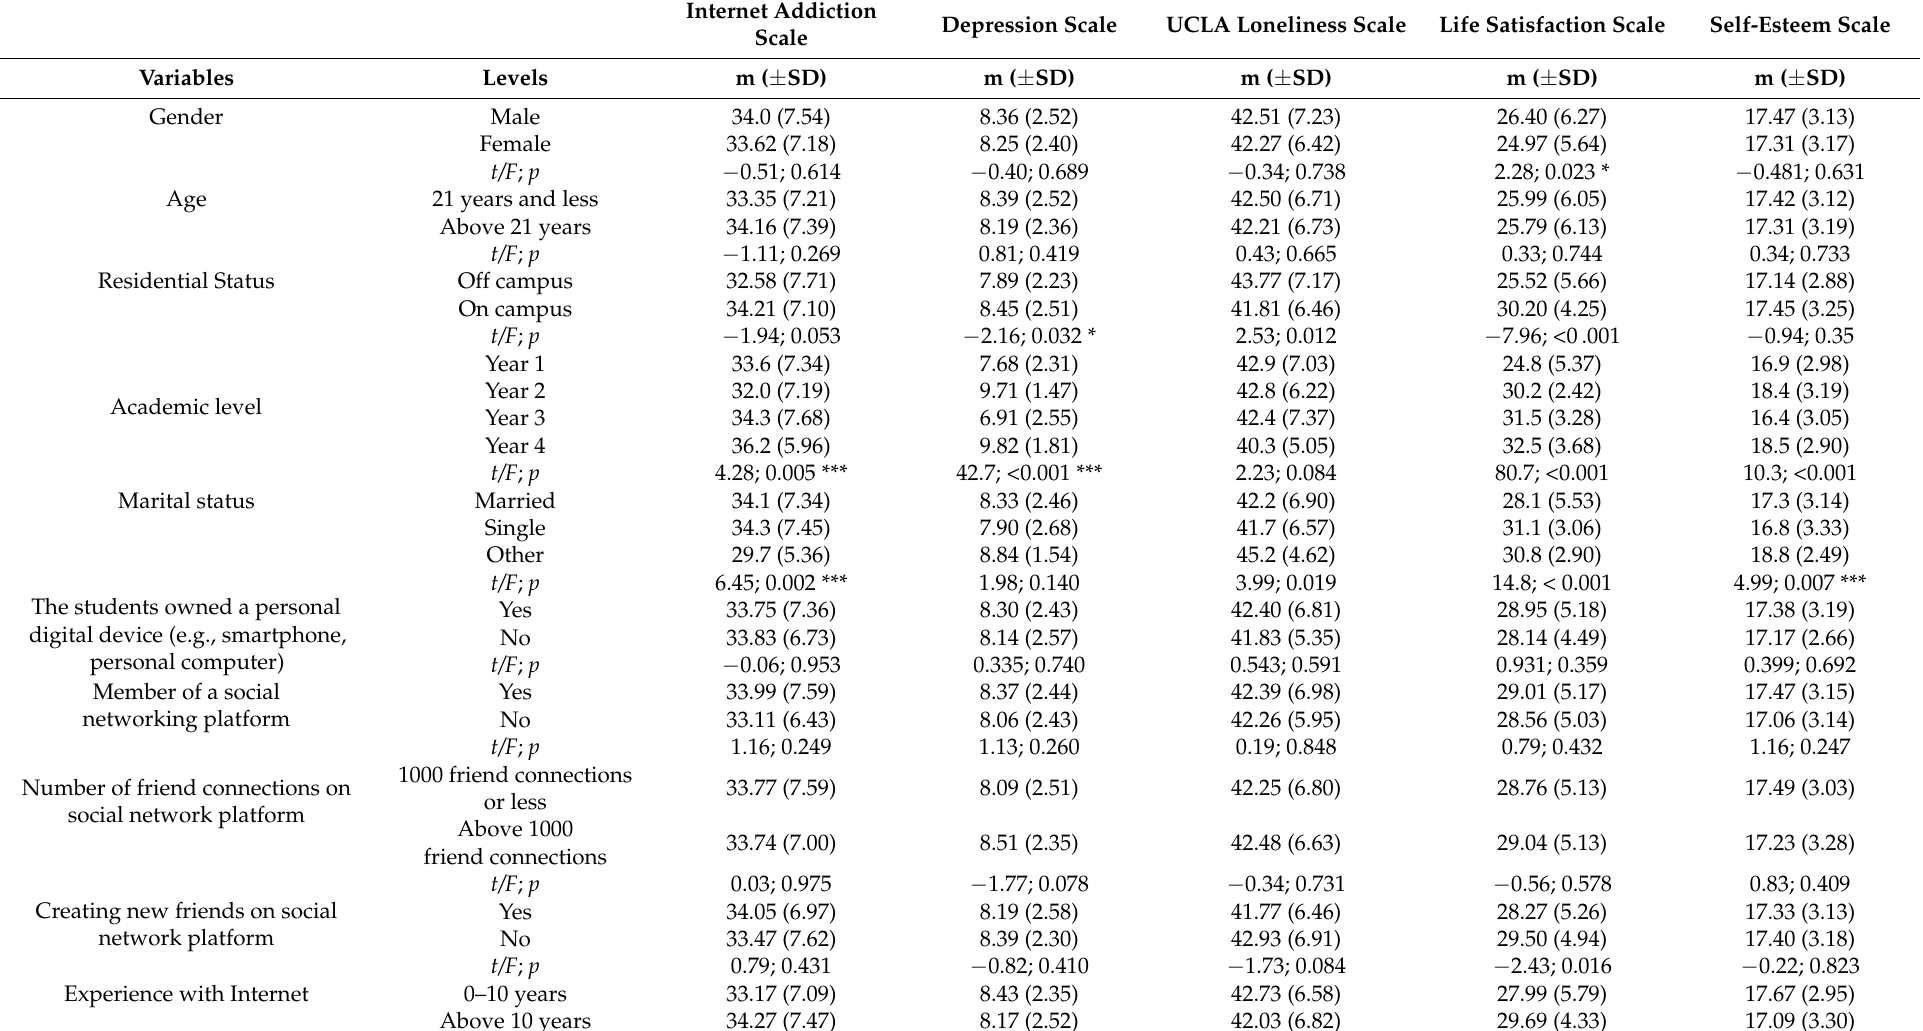
Table 3. Score analysis of the Internet Addiction Scale, Depression Scale, UCLA Loneliness Scale, and the Life Satisfaction and Self-Esteem Scale. Internet Addiction Depression Scale UCLA Loneliness Scale Life Satisfaction Scale Self-Esteem Scale